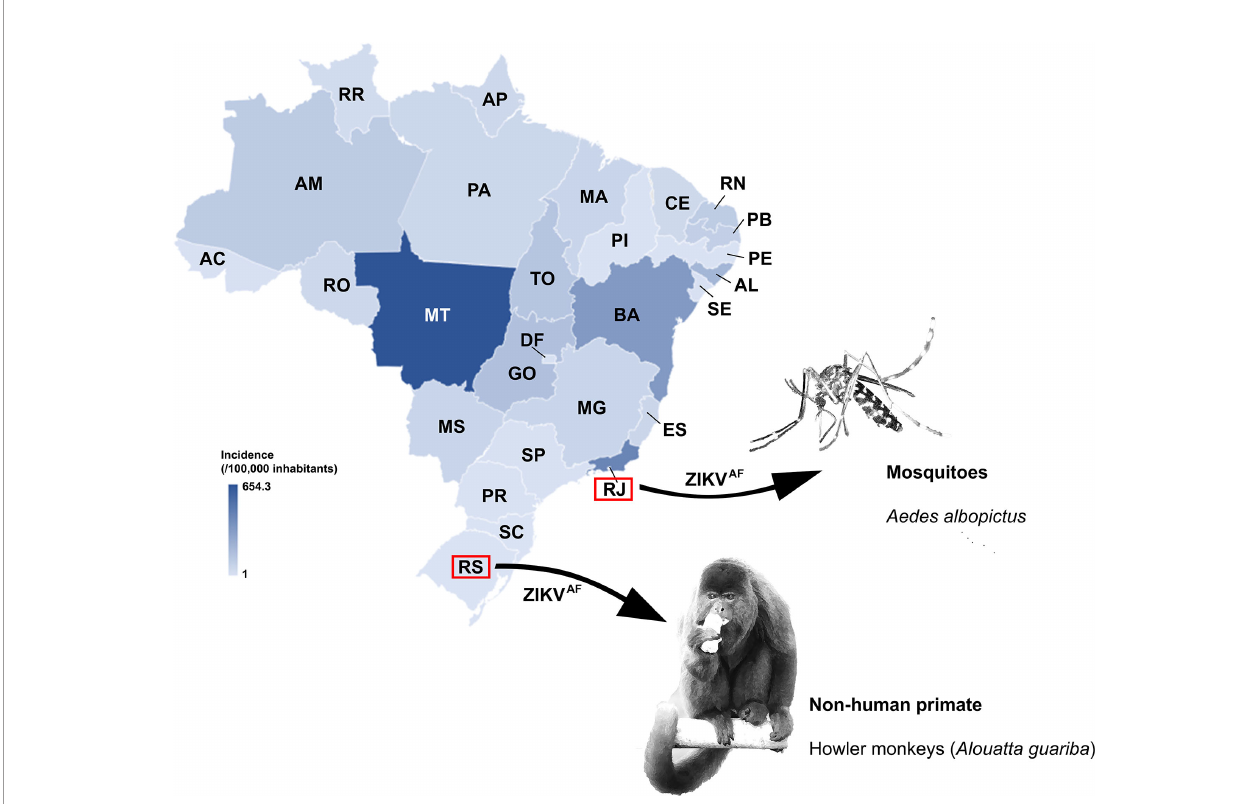
FIGURE 1 | Incidence per 100,000 inhabitants of Zika cases in Brazil reported in 2016. Color gradient representing high (darker blue) to low ZIKV incidence (lighter blue). The Brazilian states where ZIKV AF was identi fi ed in sylvatic area are also highlighted. Zika virus incidence data were recovered from Brazil Ministry of Health (2018). AC, Acre; AL, Alagoas; AP, Amapa ́ ; AM, Amazonas; BA, Bahia; CE, Ceara ́ ; DF, Distrito Federal; ES, Esp ı ́ rito Santo; GO, Goia ́ s; MA, Maranhão; MT, Mato Grosso; MS, Mato Grosso do Sul; MG, Minas Gerais; PA, Para ́ ; PB, Para ı ́ ba; PR, Parana ́ ; PE, Pernambuco; PI, Piau ı ́ ; RJ, Rio de Janeiro; RN, Rio Grande do Norte; RS, Rio Grande do Sul; RO, Rondo ̂ nia; RR, Roraima; SC, Santa Catarina; SP, São Paulo; SE, Sergipe; TO,